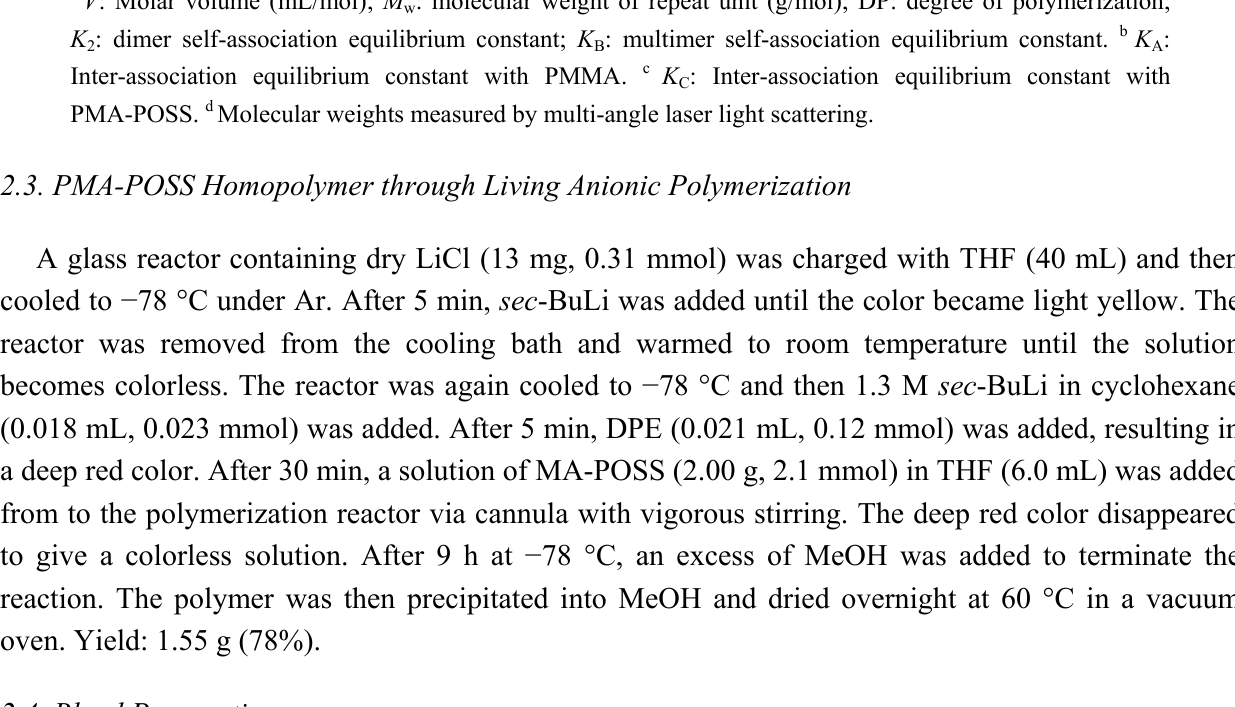
Table 1. Self-association and inter-association equilibrium constants and thermodynamic parameters for poly(methyl methacrylate) (PMMA) and polyhedral oligomeric silsesquioxane (PMA-POSS) and their blends with poly(vinyl phenol) (PVPh), phenolic, and bisphenol A (BPA) at 25 °C. Equilibrium Constant Polymer V M DP PDI w b K c K K K 2 B A C PVPh a 100 120 66 1.73 21.6 66.8 10 0 Phenolic 84 105 6 2.40 23.3 52.3 20 0 BPA 176 228 – – 21.0 66.8 20 0 PMMA d 84.9 100 403 1.04 – – – – PMA-POSS d 826 926 41 1.07 – – –